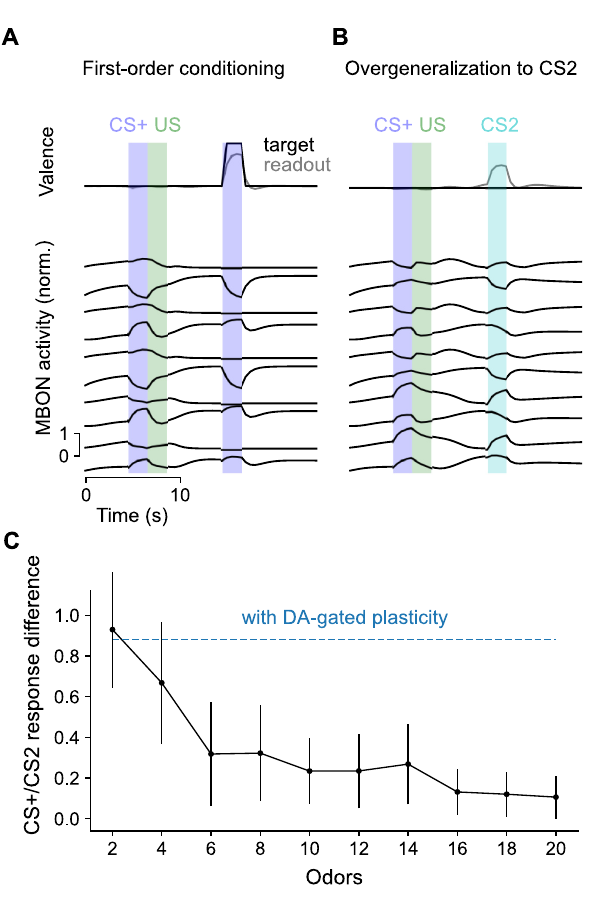
Fig 4. Comparison to networks without dopamine-gated plasticity. (A) Behavior during first-order conditioning, similar to Fig 3A, but for a non-plastic network. Because of the need for non-plastic networks to maintain information using persistent activity, performance degrades with longer delays between training and test phases. We therefore chose this delay to be shorter than in Fig 3A. Results are shown for a network optimized with 10 odors. (B) Same as A , but for a trial in which a CS-US pairing is followed by the presentation of a neutral CS. (C) Difference in response (reported valence) for CS+ and neutral CS as a function of the number of odors. Each CS+ is associated with either a positive or negative US. For comparison, the corresponding response difference for networks with dopamine-gated plasticity is shown in blue. Error bars represent s.e.m. over 8 network